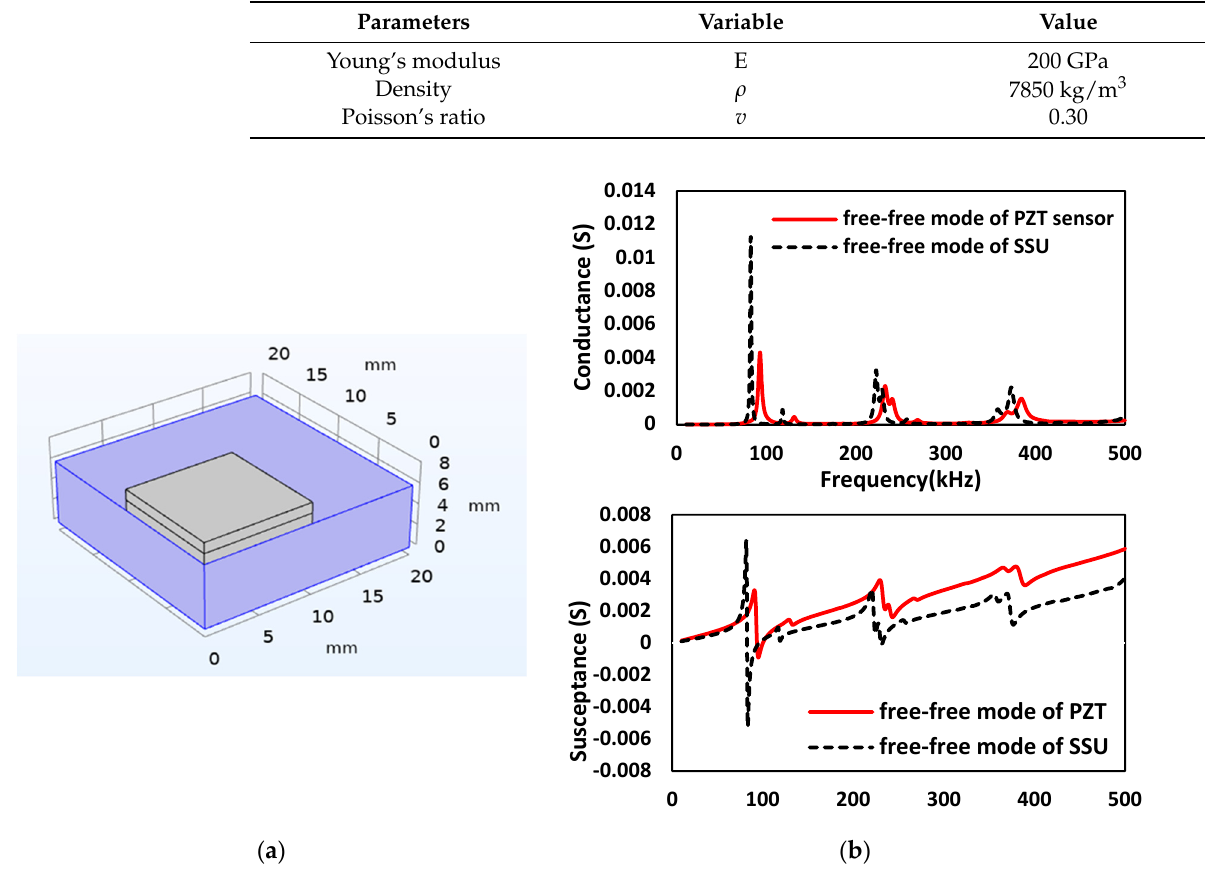
Figure 10. EMI response of SSU: ( a ) Schematic two-sided symmetry model of SSU; ( b ) Conductance and susceptance signatures obtained in a free–free mode of PZT sensors (without steel plate) and free–free mode SSU (with steel plate).